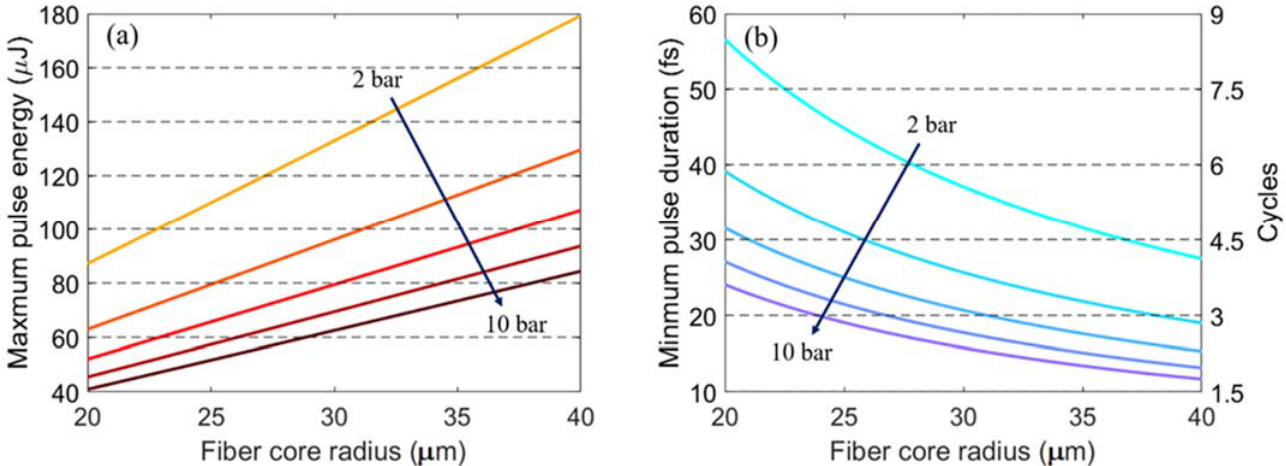
Figure 1. Dependence of E max ( a ) and T min ( b ) on the HCF core radius with the helium pressure at 2 bar, 4 bar, 6 bar, 8 bar, and 10 bar. The pulse is centered at 2 μ m.